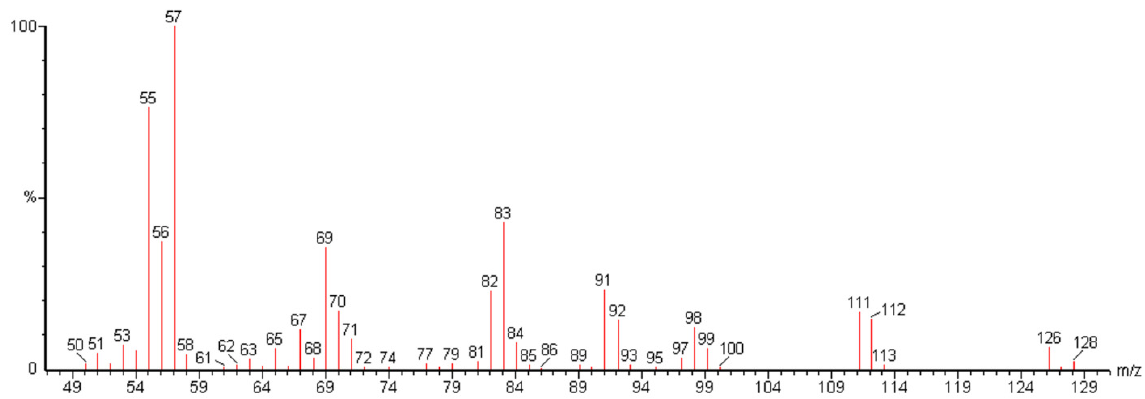
Figure 5. MS spectrum for the peak with a retention time of 8.20 min.